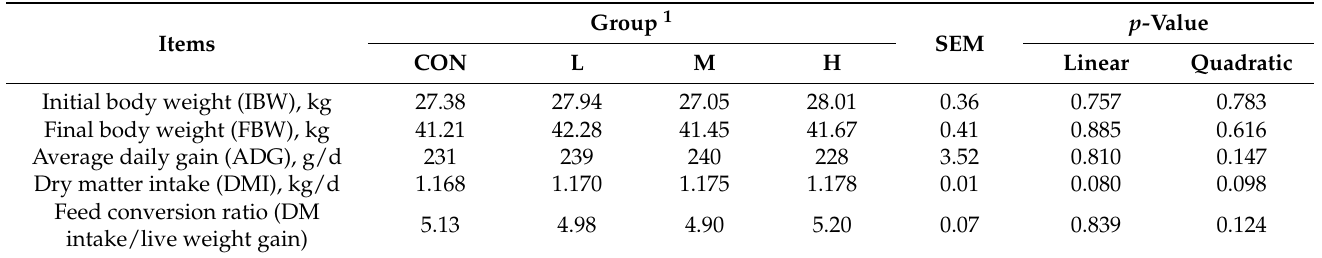
Table 3. Effects on growth performance of Hu lambs by substituting 0 (CON group), 20 (L